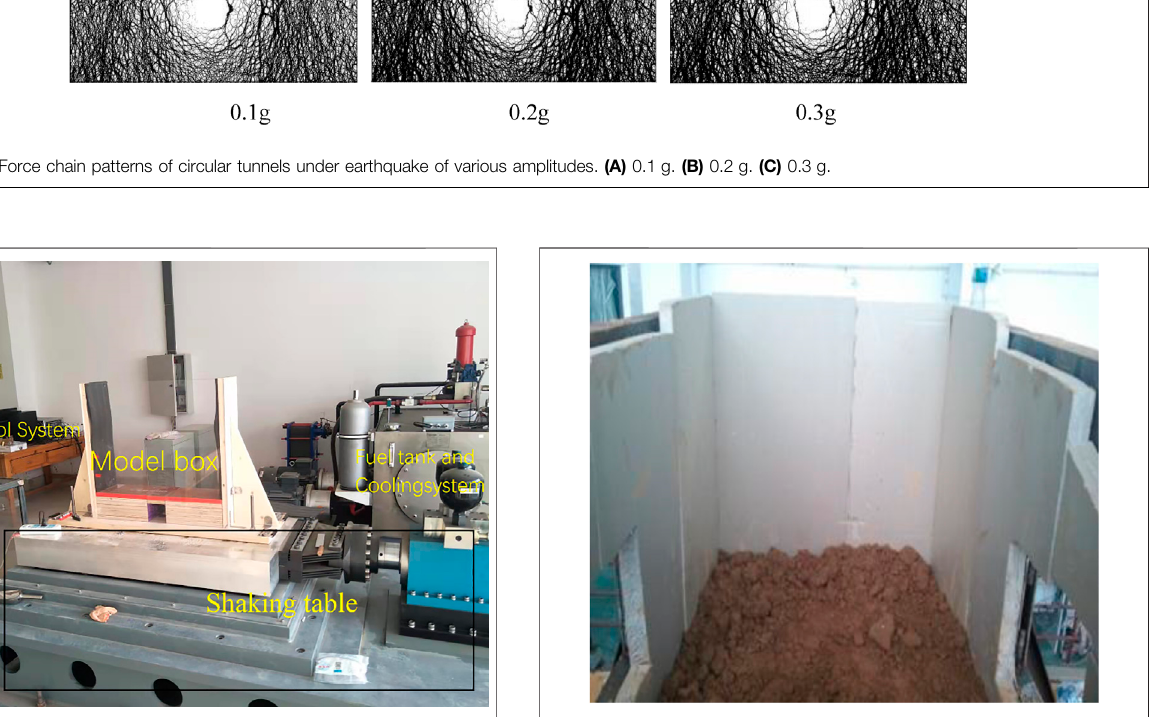
FIGURE 10 | Shaking table and model